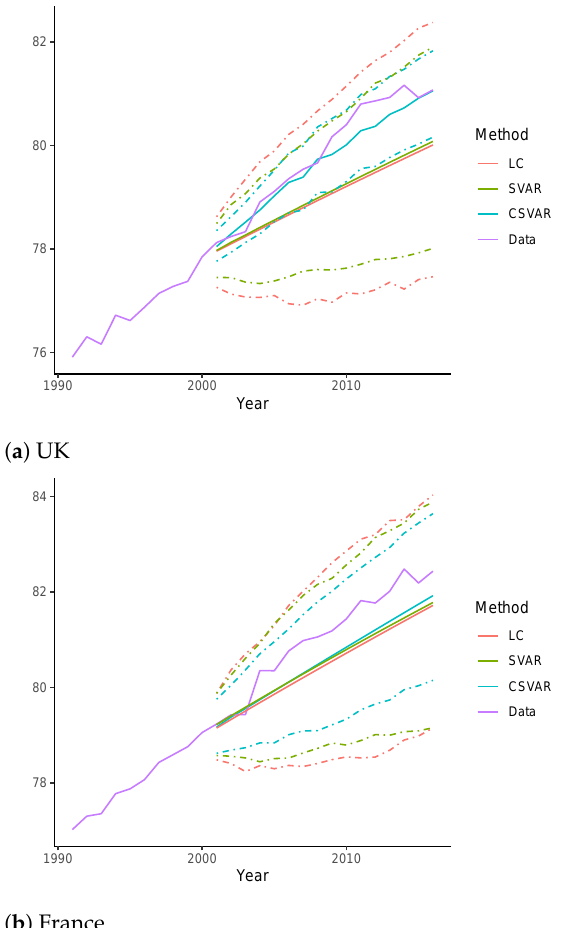
Figure 6. Forecast vs actual life expectancy at age 0: